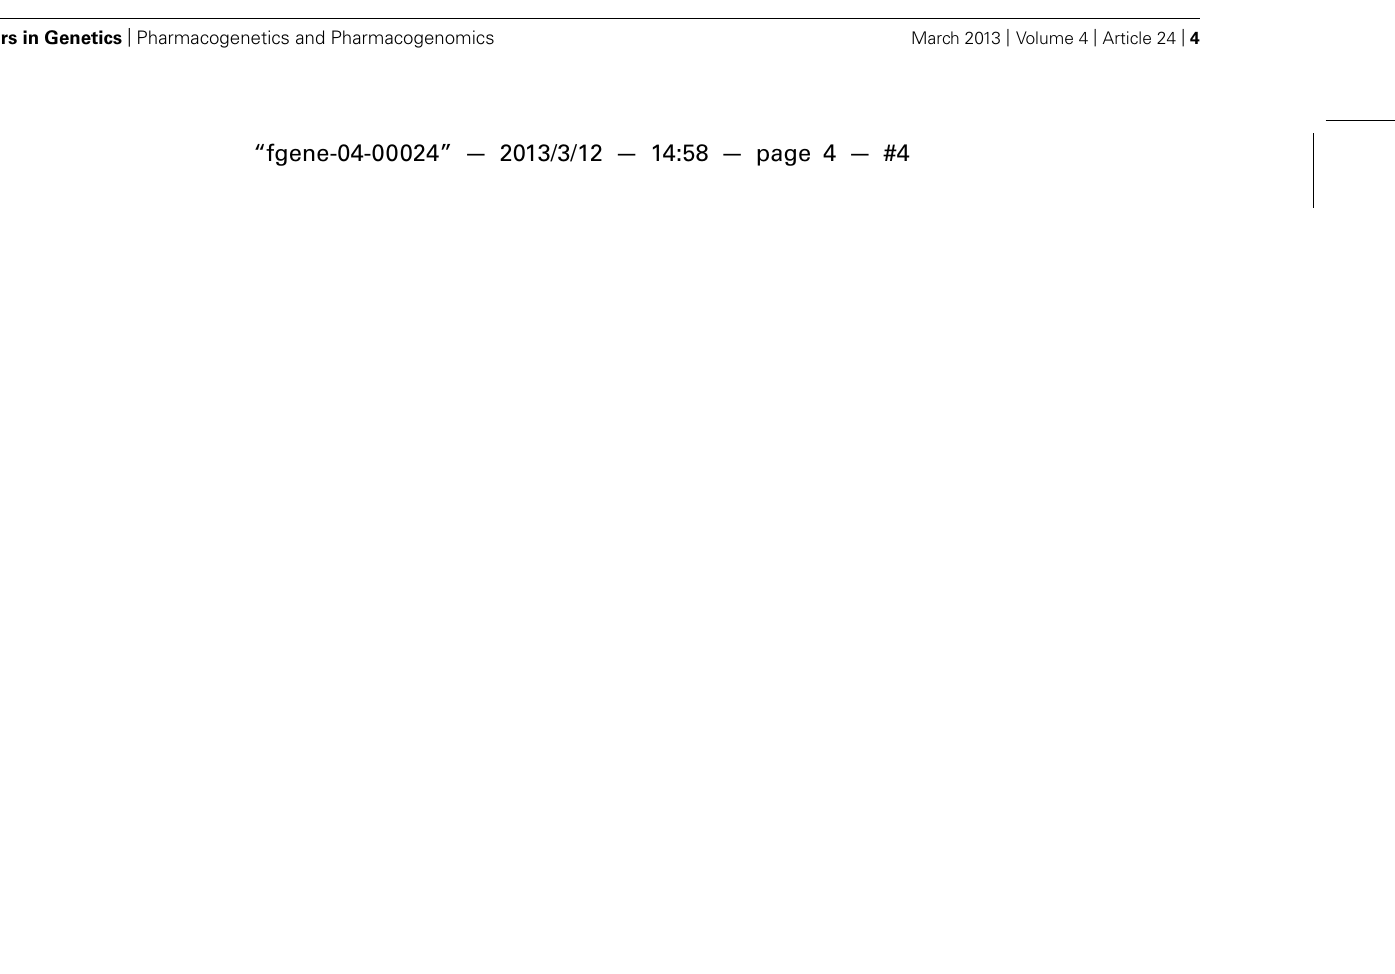
c Selected frequencies of individual ethnicities (AA, African American; Af African; As Asian; Ca Caucasian; Hs, Hispanic; PNG, Papua New Guineans) compiled from dbSNP http://www.ncbi.nlm.nih.gov/SNP and from the literature cited in the